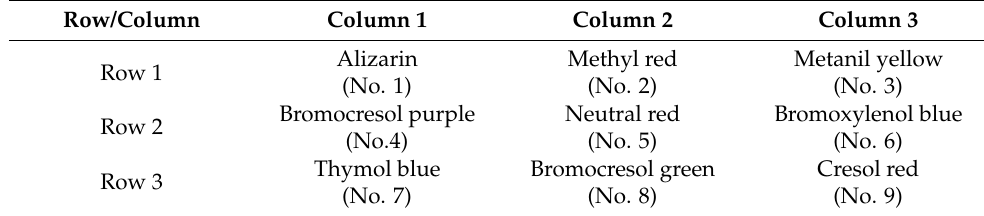
Table 1. The dyes on PVDF membrane (3 × 3 cm 2 ) for colorimetric sensor array. Row/Column Column 1 Column